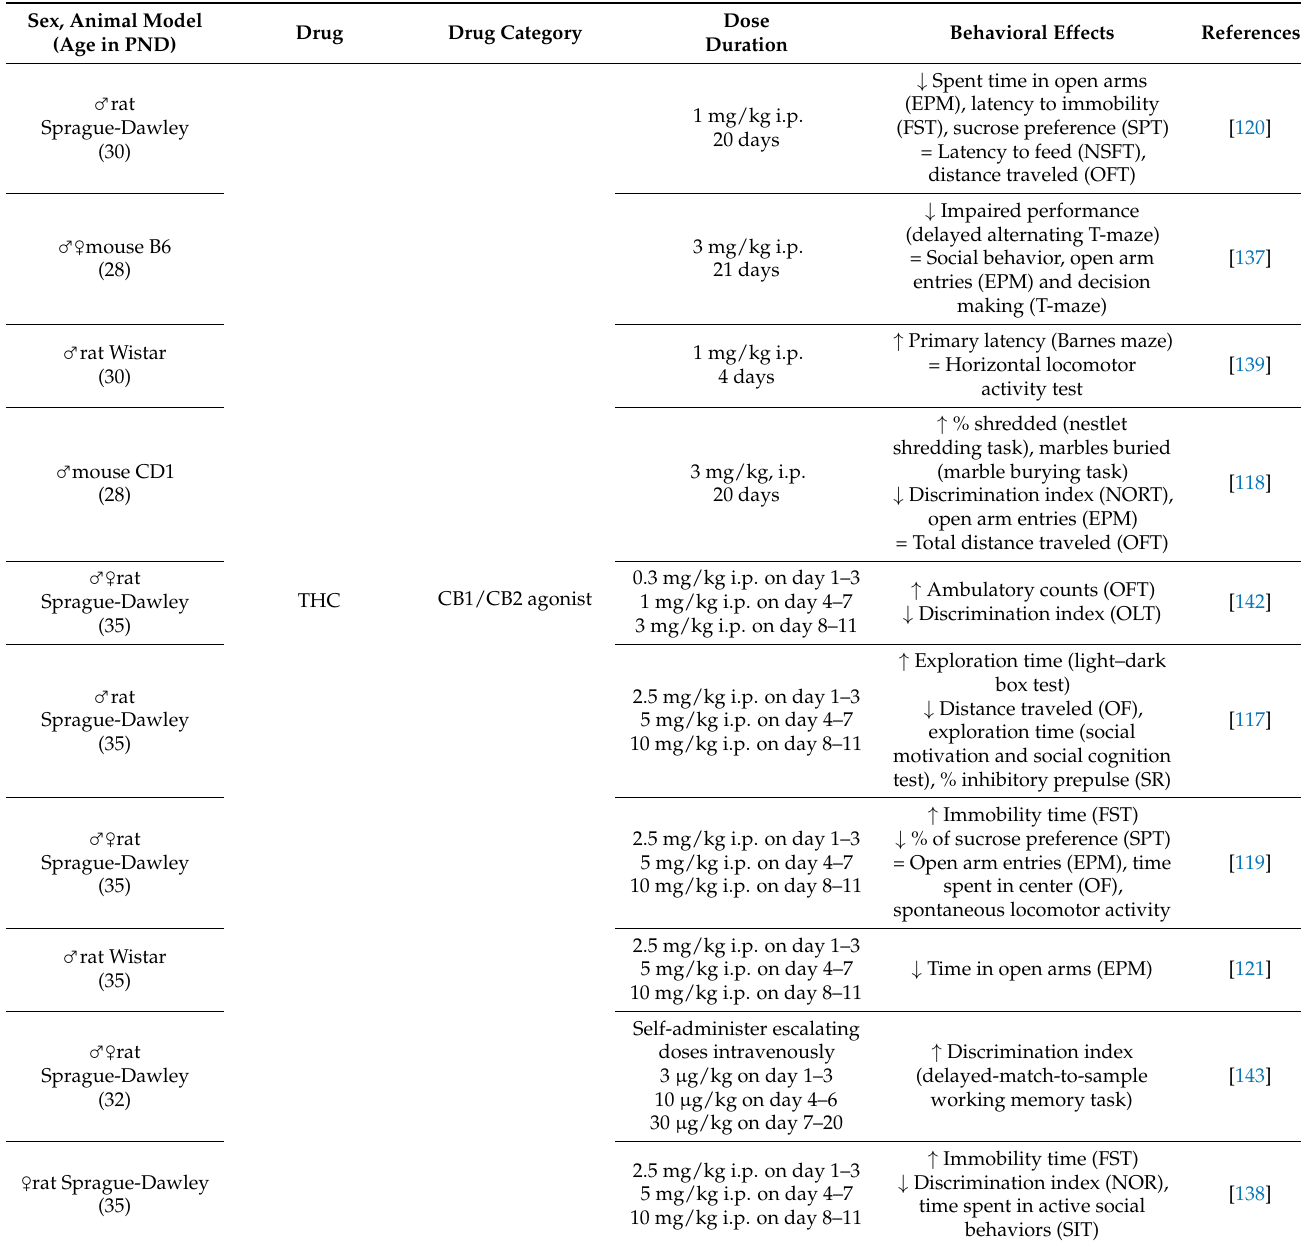
Table 7. Effects of the ECS modulation on